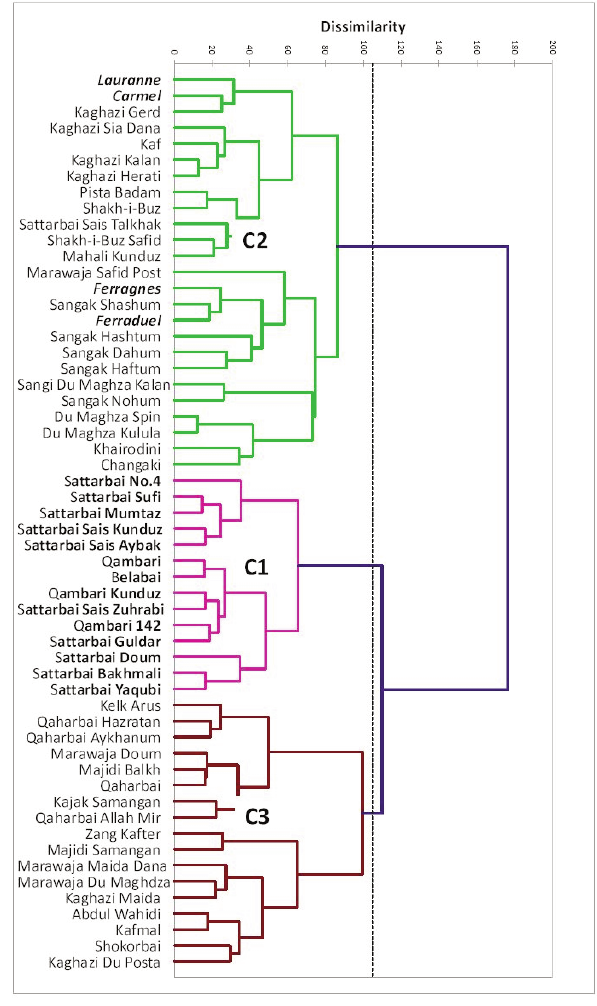
Fig. 1 - Dendrogram (Euclidean distance; Ward's agglomerating method) obtained by analyzing 48 multi-state, discrete morphological variables of 56 almond accessions belonging to the National Collection of Fruits and Nuts of Afghanistan (bold cursive: International cultivars; bold: accessions belonging to C1 cluster "Sattarbai